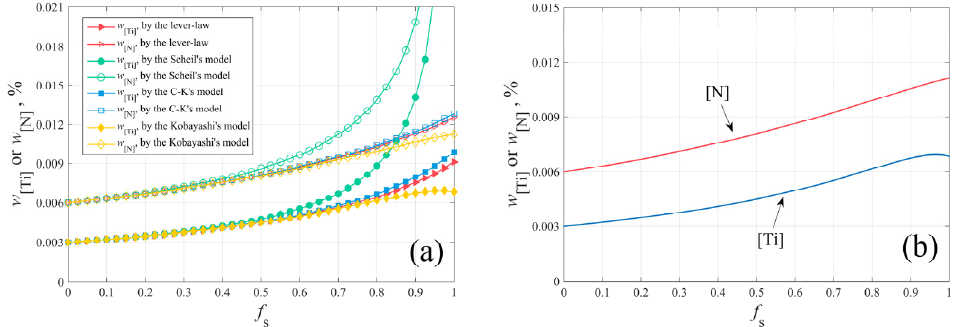
Figure 2. The solidification segregation of Ti and N in GCr15 bearing steel: ( a ) based on the different segregation models; ( b ) based on the segregation model by Kobayashi.